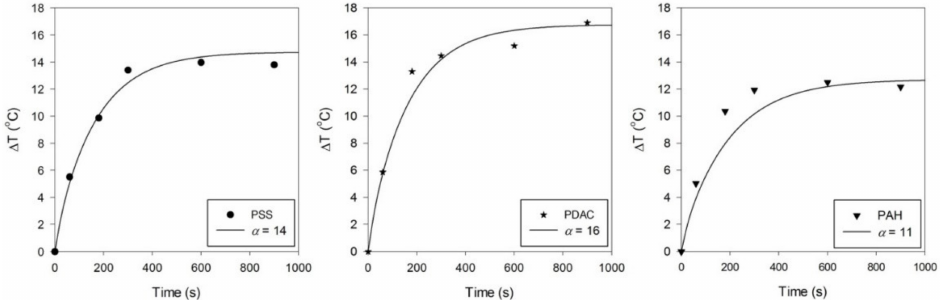
Figure 8. Temperature increase of 100 µ L Milli-Q water with PSS-GNRs, PDAC-GNRs, and PAH- GNRs after exposure to a 650 mW laser (at a wavelength of 635 nm), compared with the simulation results (solid lines) measured at r = 0.001 m and z = − 0.0015 m. The circle, star, and inverted triangle symbols present experimental